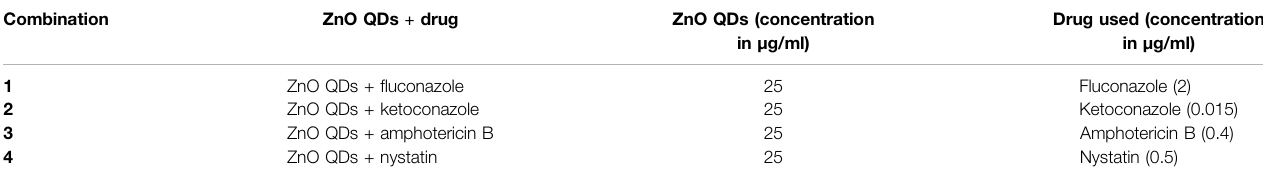
The bold represents a particular drug combination and the respective detail is provided in the next column only as ZnO QDs +Fluconazole , ZnO QDs +Ketoconazole, ZnO QDs +Amphotericin B And ZnO QDs +Nystatin. No further explanation is